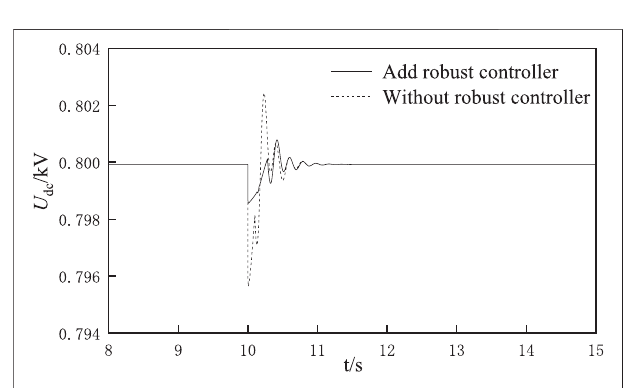
FIGURE 8 | DC bus voltage waveform when an electric vehicle is connected to the